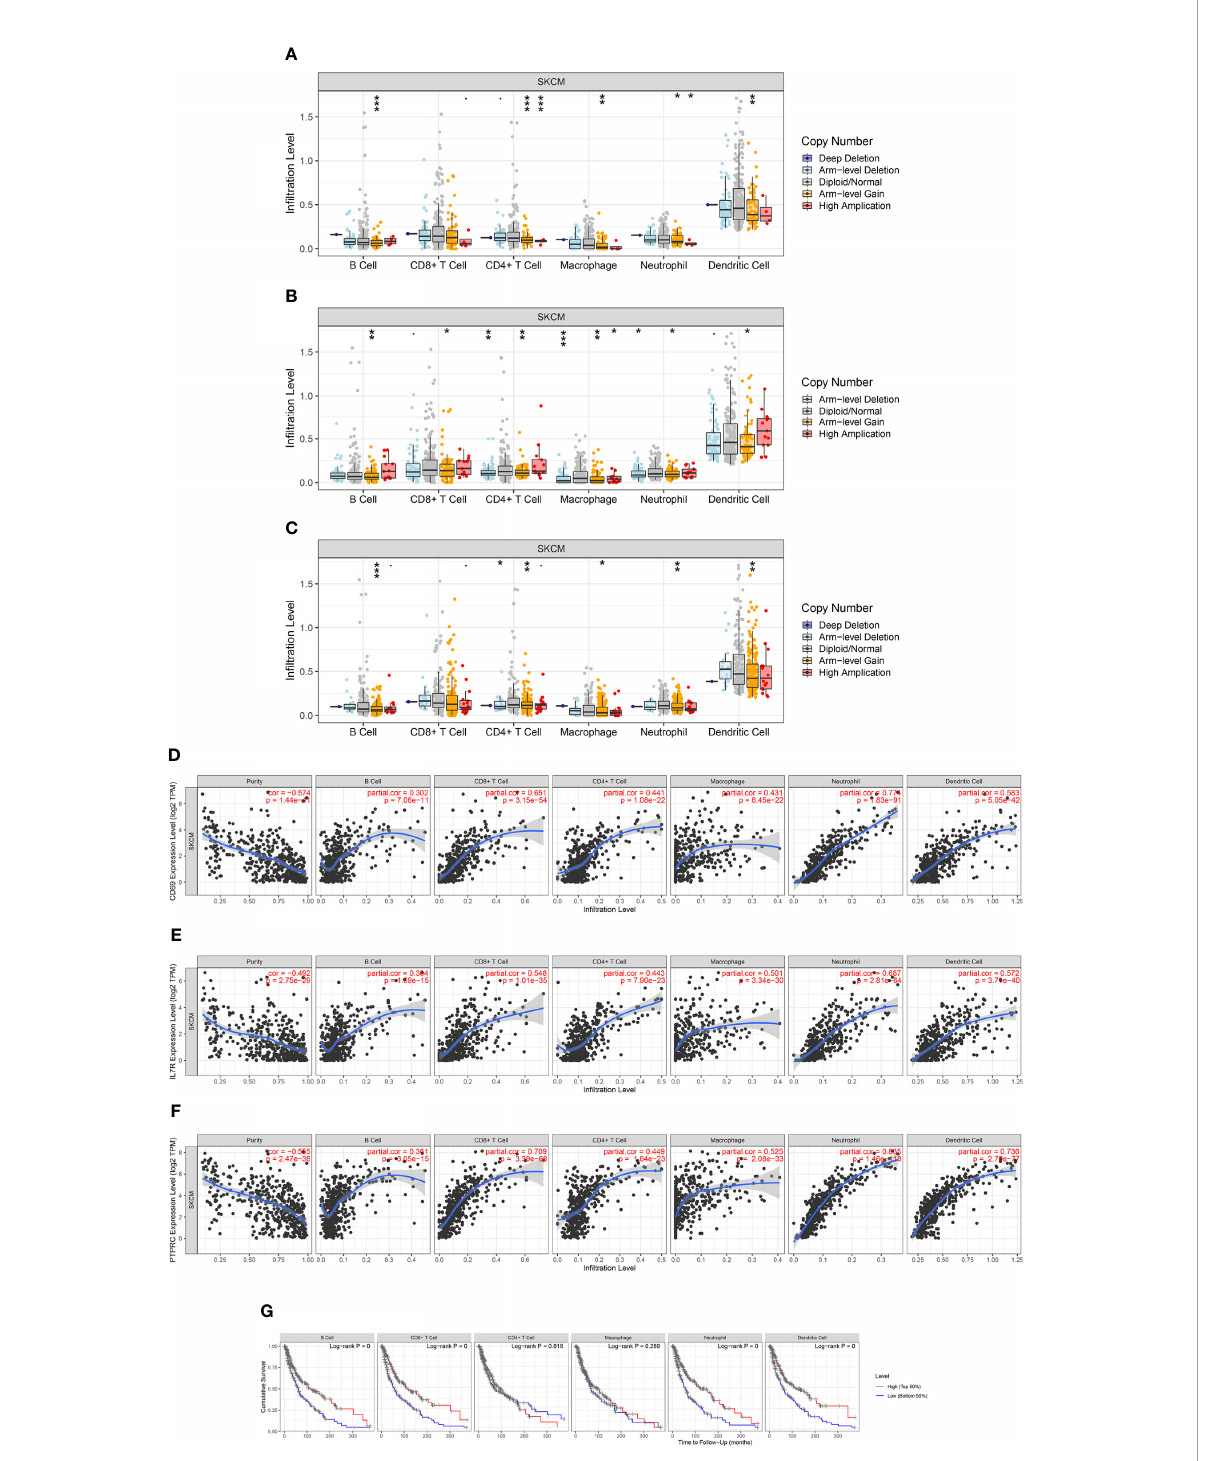
FIGURE 9 Correlation analysis of CD69 , IL7R , and PTPRC expression and immune in fi ltration in SKCM. (A – C) Relationship between CD69 , IL7R , and PTPRC gene copy number and immune cell in fi ltration levels in SKCM cohorts, including B cells, CD4+ T cells, macrophages, neutrophils, and dendritic cells. (D – F) Interaction correlation of CD69 , IL7R , and PTPRC expression with immune in fi ltration level in SKCM, including B cells, CD4+ T cells, macrophages, neutrophils, and dendritic cells. (G) Kaplan – Meier plots showing the impact of immune in fi ltration level of various cells, including B cells, CD4+ T cells, macrophages, neutrophils, and dendritic cells, on the overall survival rate of SKCM patients. *p < 0.05, **p < 0.01, ***p <